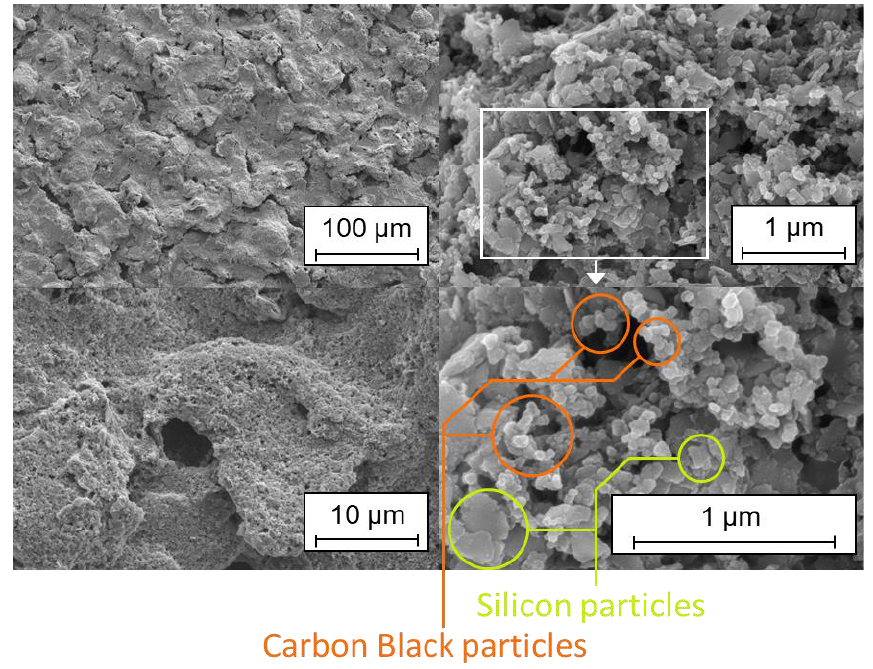
Figure A3. Top view of an exemplary silicon-rich anode (area capacity: 2 mAh · cm − 2 ) with four different resolution levels.